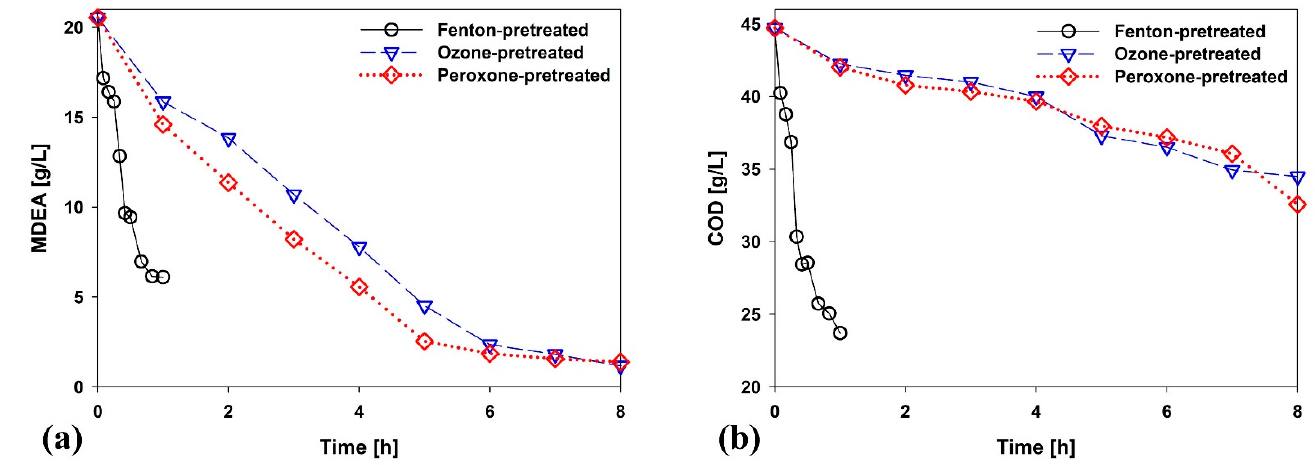
Figure 3. MDEA and COD concentration profiles during the advanced oxidation pretreatment tests: ( a ) MDEA and ( b ) COD. ( a ) MDEA and ( b ) COD.